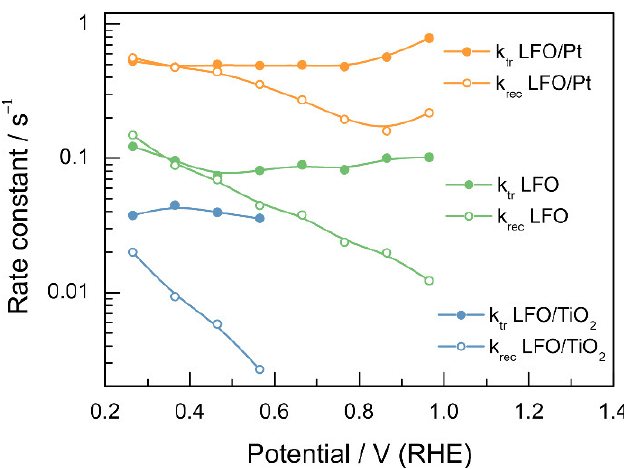
Figure 7. Potential dependence of the charge transfer rate constant and recombination rate constant, as determined from transient photocurrent measurements.